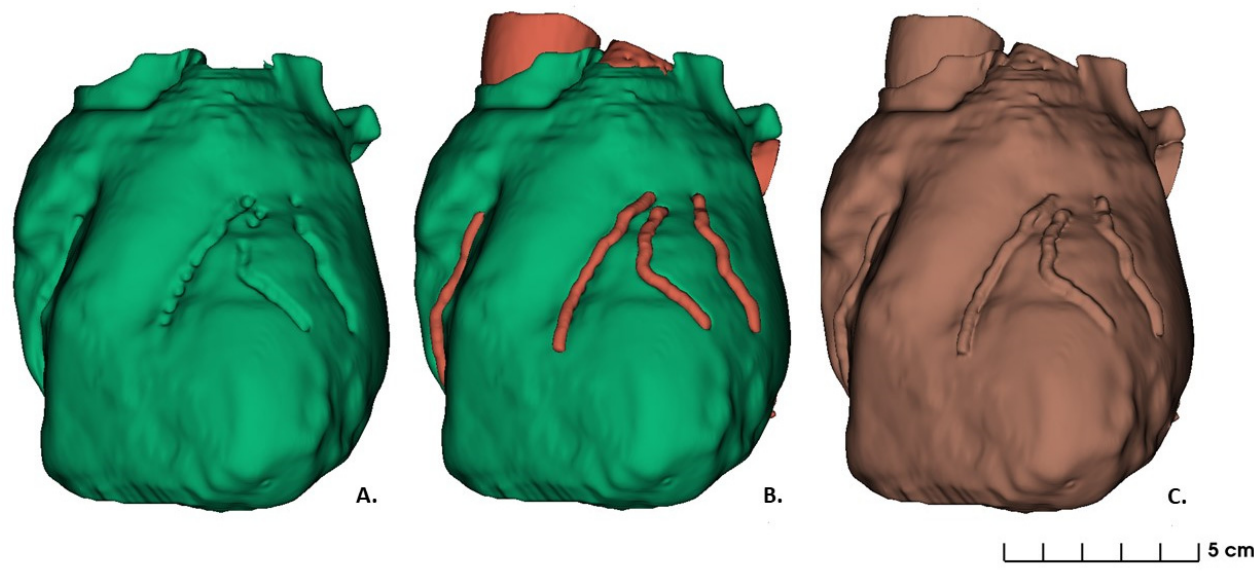
Figure 2. Heart model segmented: ( A ) First stage segmentation of whole heart without coronary artery tree; ( B ) Second stage segmentation as a combination of whole heart and coronary arteries; ( C ) Final segmentation stage.